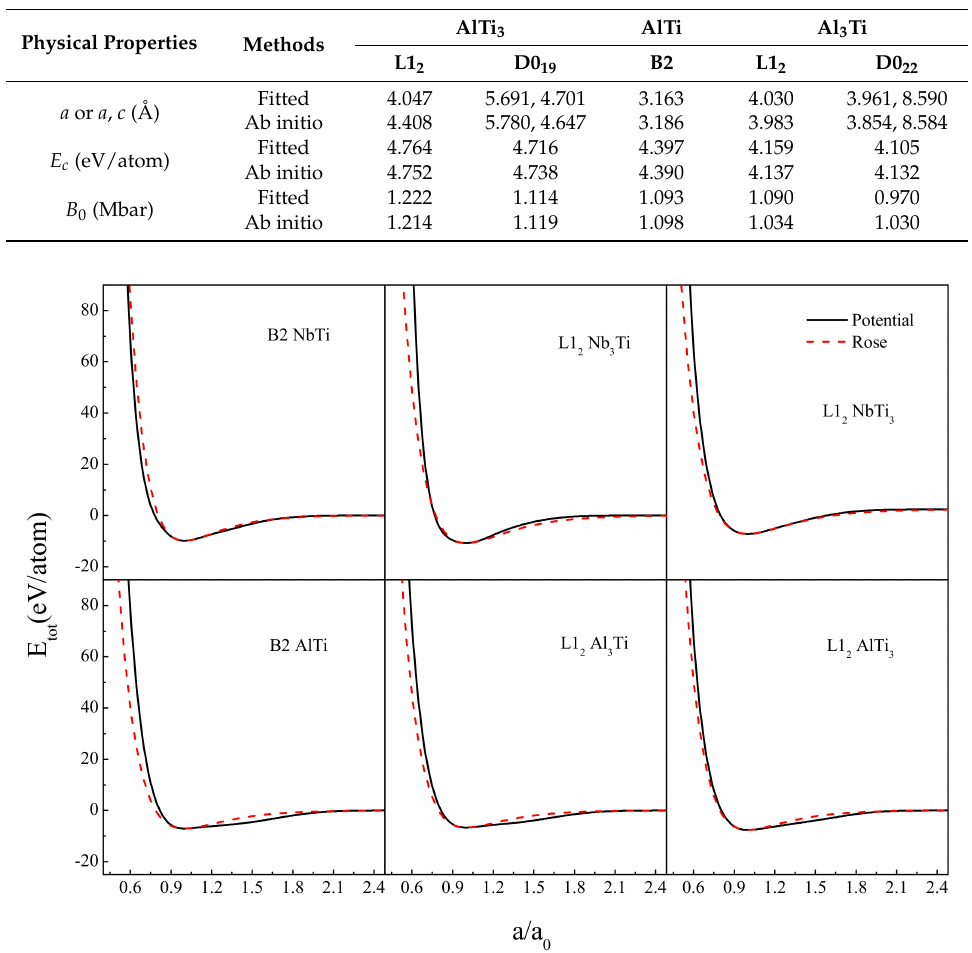
Table 4. The lattice constants ( a , c ), cohesive energies ( E c ), and bulk modulus ( B 0 ) of Ti-Al hypothetical compounds fitted by the potential and calculated from ab initio (second line).